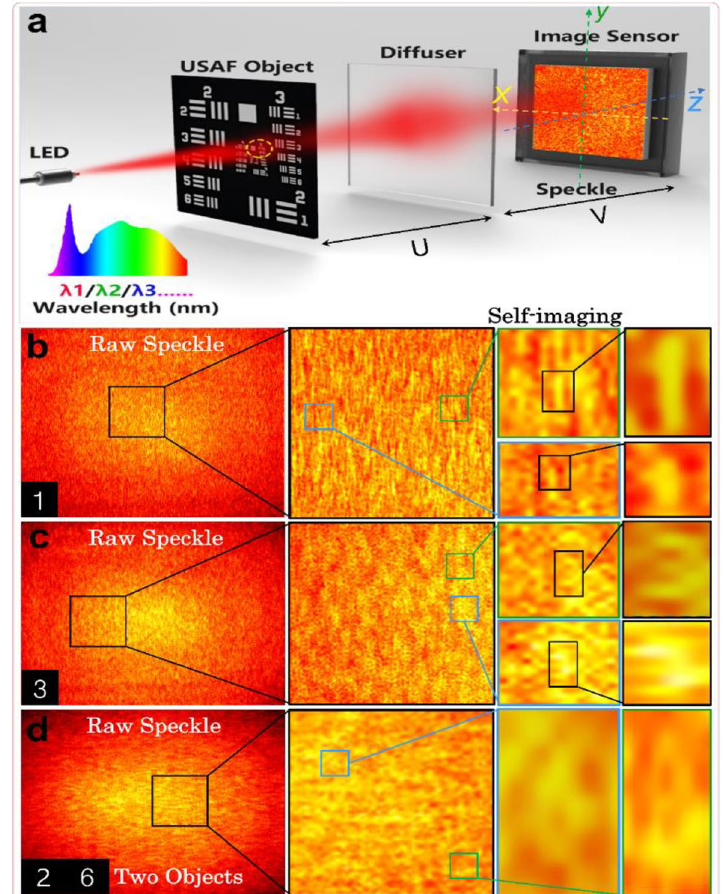
Fig. 1 Direct observation of self-imaging in raw speckles. a The schematic of the diffuser imaging system. b-d Experimental observation of self-imaging in speckles. Camera captured original raw speckles of isolated objects of ( b ) digit ‘1’, ( c ) digit ‘3’, and ( d ) multi-objects ‘2’ and